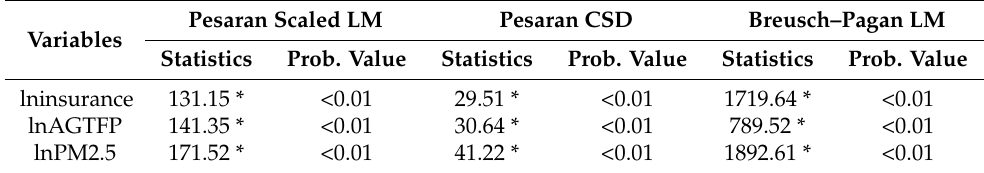
Table 2. The results of cross-sectional dependence tests.